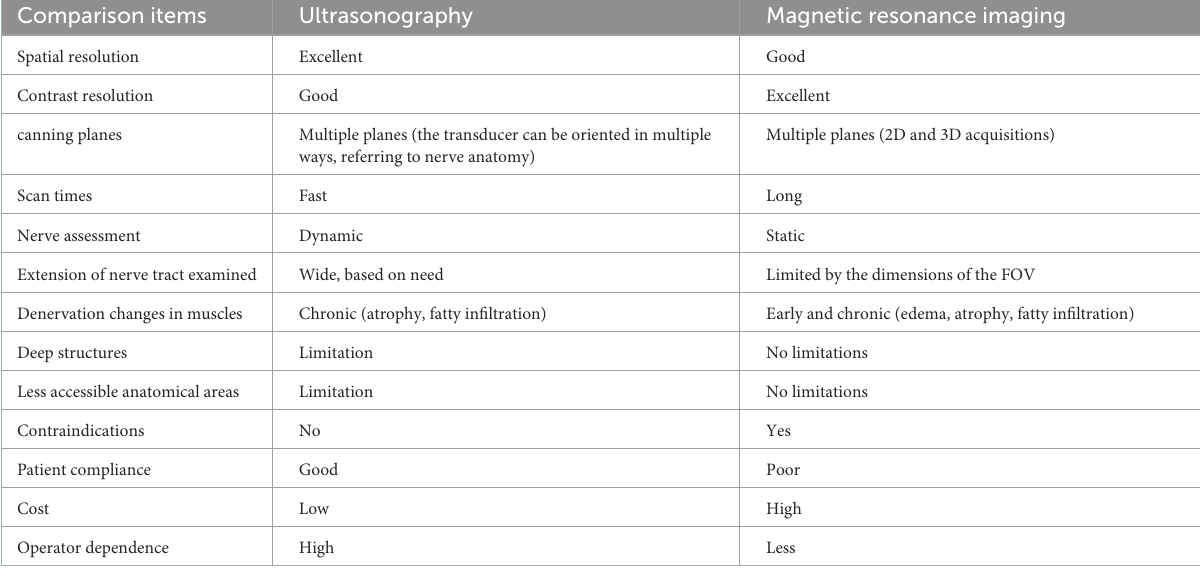
TABLE 2 Advantages and disadvantages of US and MRI in the traumatic damage to peripheral nerves. Comparison